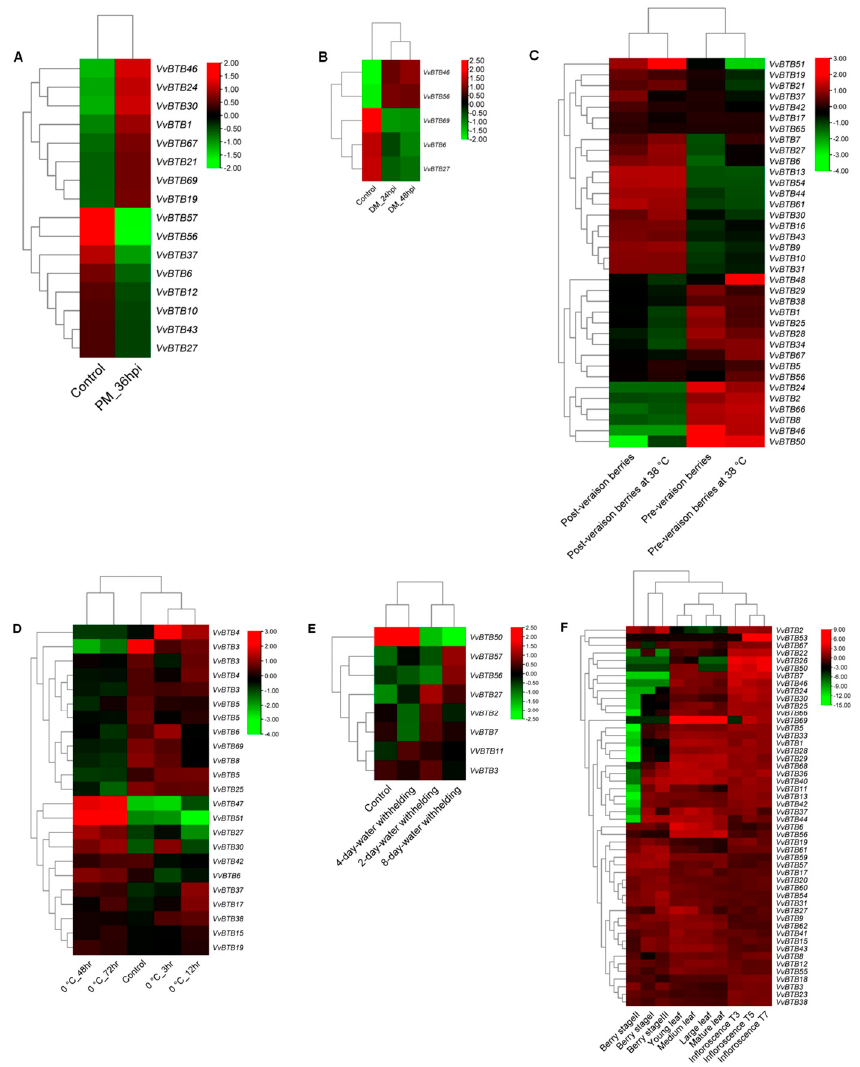
Figure 5. Heat maps depicting expression profiles of VvBTB genes in ( A ) PM infection (powdery mildew infection at 36 hpi), ( B ) DM (downy mildew infection at 24 and 48 hpi), ( C ) heat stress, ( D ) cold stress, ( E ) drought and ( F ) developmental stages. Heat maps were generated using TBtools. Color bars for each heat map indicate relative expression. Red color represents upregulation, black color represents no change in expression, and green color represents downregulation .